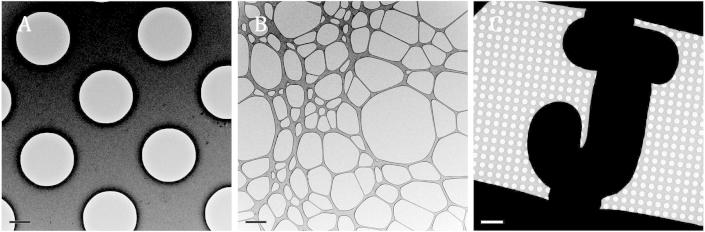
Examples of EM support films. A) Holey carbon, such as Quantifoil® R2/2 (2 μm holes separated by 2 μm), Scale bar 1 μm. B) Lacy carbon film (irregular network of thin carbon), Scale bar 1 μm. C) Finder grid (here with Quantifoil® R2/2 carbon), scale bar 10 μm.